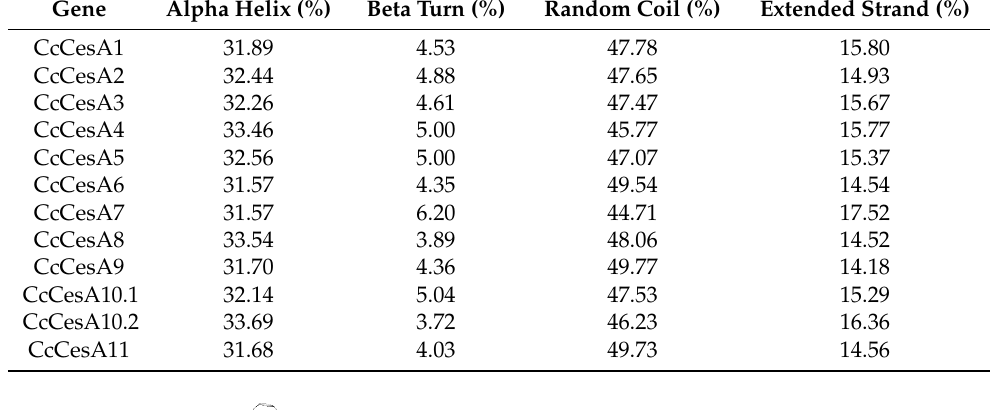
Table 3. Secondary protein structure of CcCesAs.